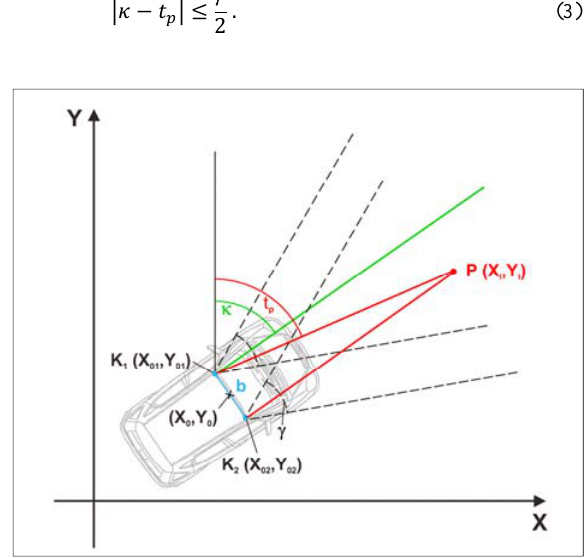
Figure 2. Visibility